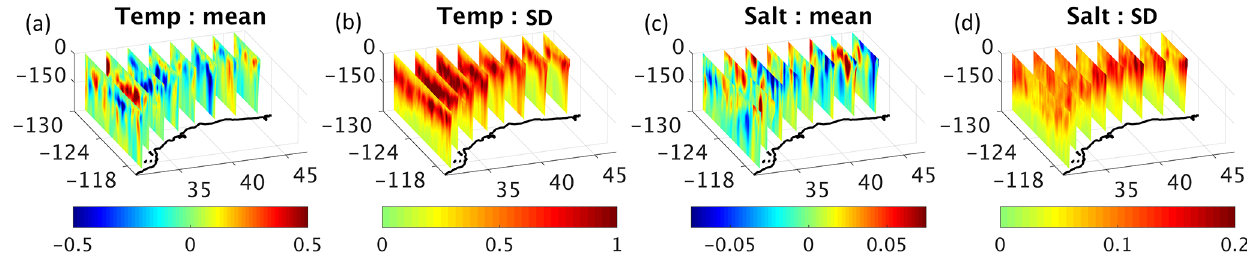
Figure 14. Vertical sections of the mean weak minus strong constraint 4D-Var differences for (a) temperature and (c) salinity for the experiment BHM estimates during 2005. The standard deviation for the (b) temperature and (d) salinity weak minus strong constraint differences are also shown.